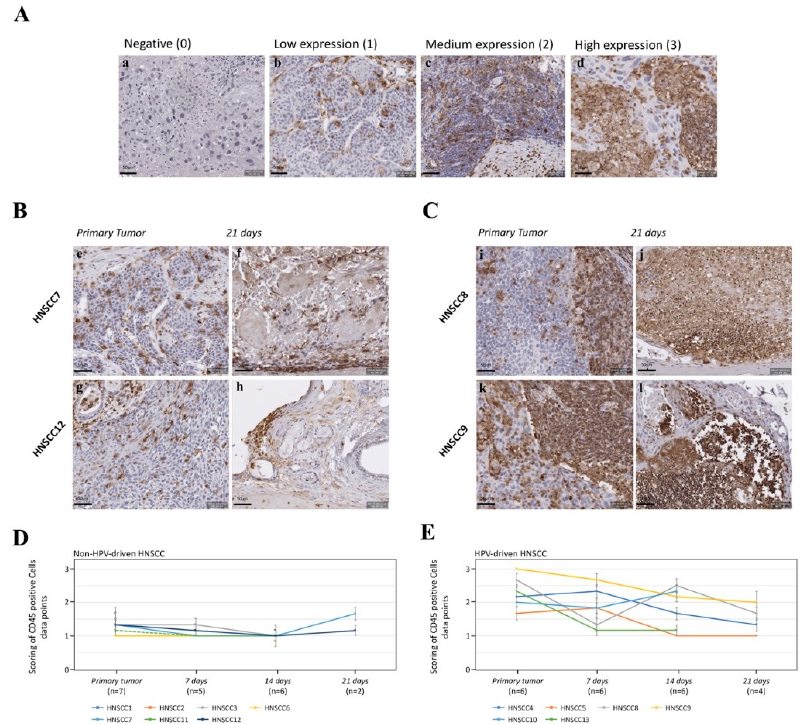
Figure 6. ( A ) Images of IHC with an anti ‐ CD45 antibody. Scoring scale for semiquantitative analysis of immune cell proportion. (a) is negative (0) for CD45, (b) shows low expression (1), (c) moderate expression (2) and d high expression (3) of CD45. ( B ) Representative images of IHC staining of two non-HPV-driven 3D-OTC on day 21 (f,h) and respective primary tumors (e,g) to identify immune cells. HNSCC7 and HNSCC12 show a comparable immune cell proportion. ( C ) Representative images of IHC staining of two HPV-driven 3D-OTC on day 21 (j,l) and respective primary tumors (i,k). HNSCC8 and HNSCC9 show comparably high amounts of immune cells in primaries and 3D-OTC. ( D ) Mean values of scores for CD45-positive, nuclei-positive cells of primaries and 3D-OTCs on day 7, 14, and 21 of all non-HPV-driven HNSCC. Error bars indicate standard errors of the mean. ( E ) Mean values of scores for CD45-positive, nuclei-positive cells of primaries and 3D-OTCs on day 7, 14, and 21 of all HPV-driven HNSCC. Error bars indicate standard errors of the mean. Scale Bar: 50 µ m. Abbreviations: HPV, human papillomavirus; 3D-OTC, 3D organotypic co-culture; HNSCC, head and neck squamous cell carcinoma; IHC,